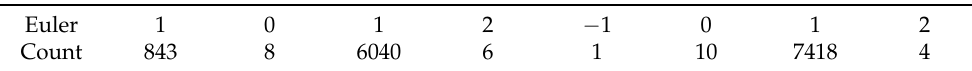
Table 6. First, second and third decomposition types (from left to right)—distributions of combinato- rial Euler characteristics of triangle complexes from border interior